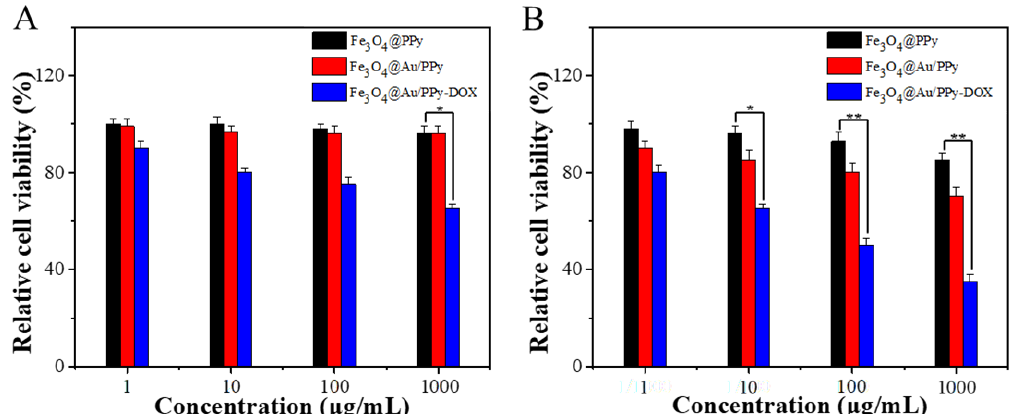
Figure 5. Viability of HeLa cells incubated with different concentrations of Fe 3 O 4 @PPy, Fe 3 O 4 @Au/PPy and Fe 3 O 4 @Au/PPy-DOX (the weight ratio of DOX to Fe 3 O 4 @Au/PPy was 2.0:1) ( A )